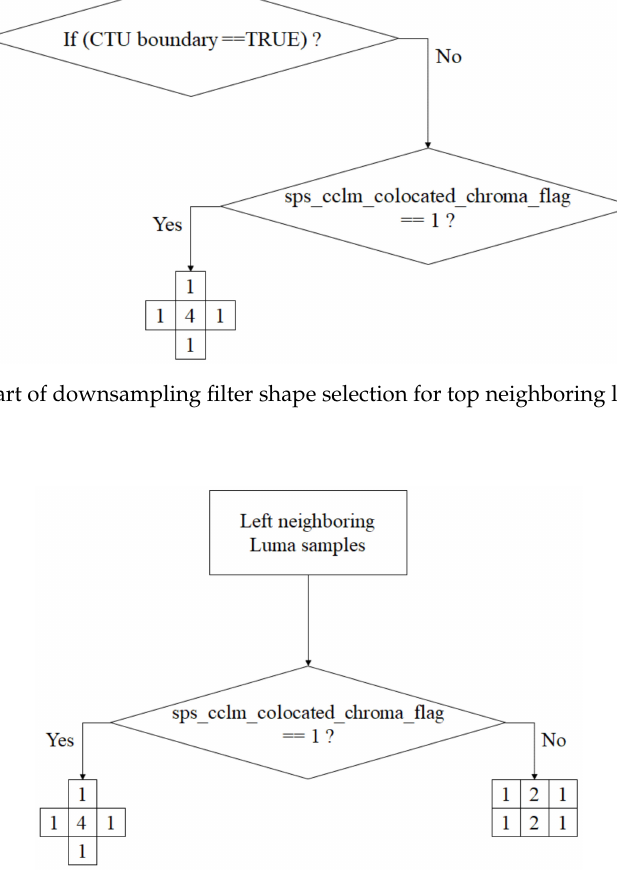
Figure 12. Flow chart of downsampling filter shape selection for left neighboring luma samples in the proposed